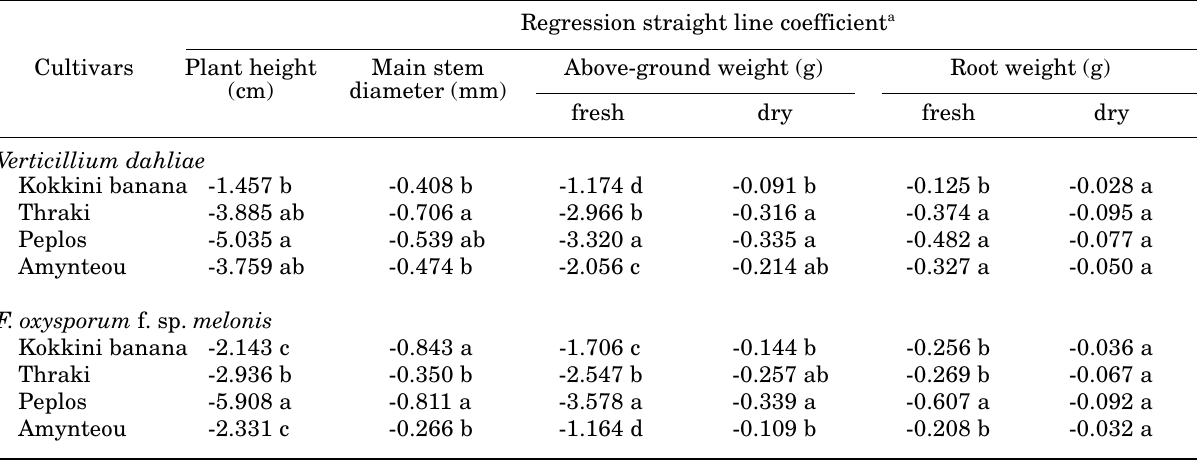
Table 2. Regression straight line coefficient between the disease index (DI) and some growth characteristics of four melon cultivars infected with Verticillium dahliae and Fusarium oxysporum f. sp. melonis in 1998 and